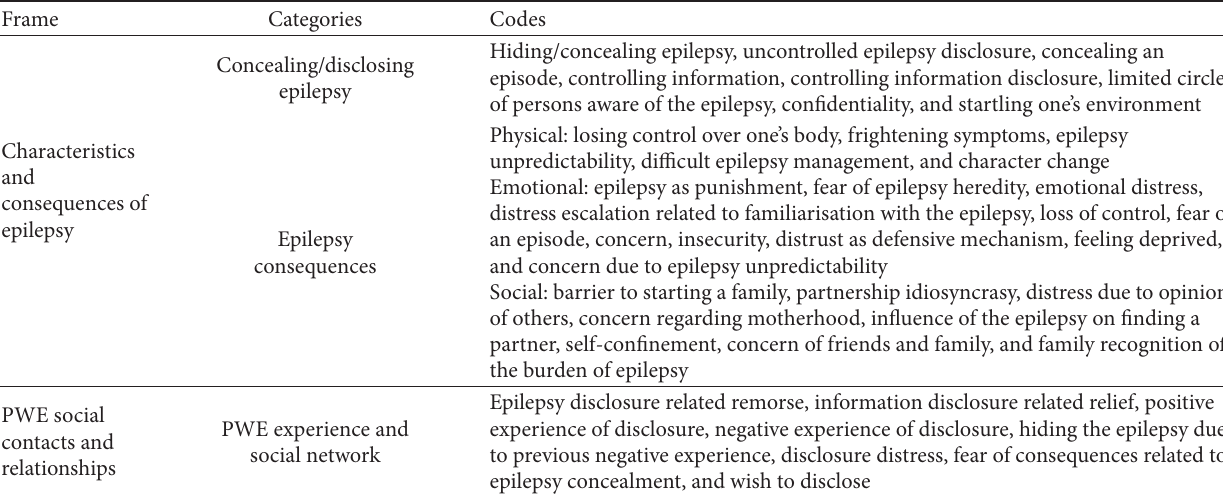
Table 2: Themes and